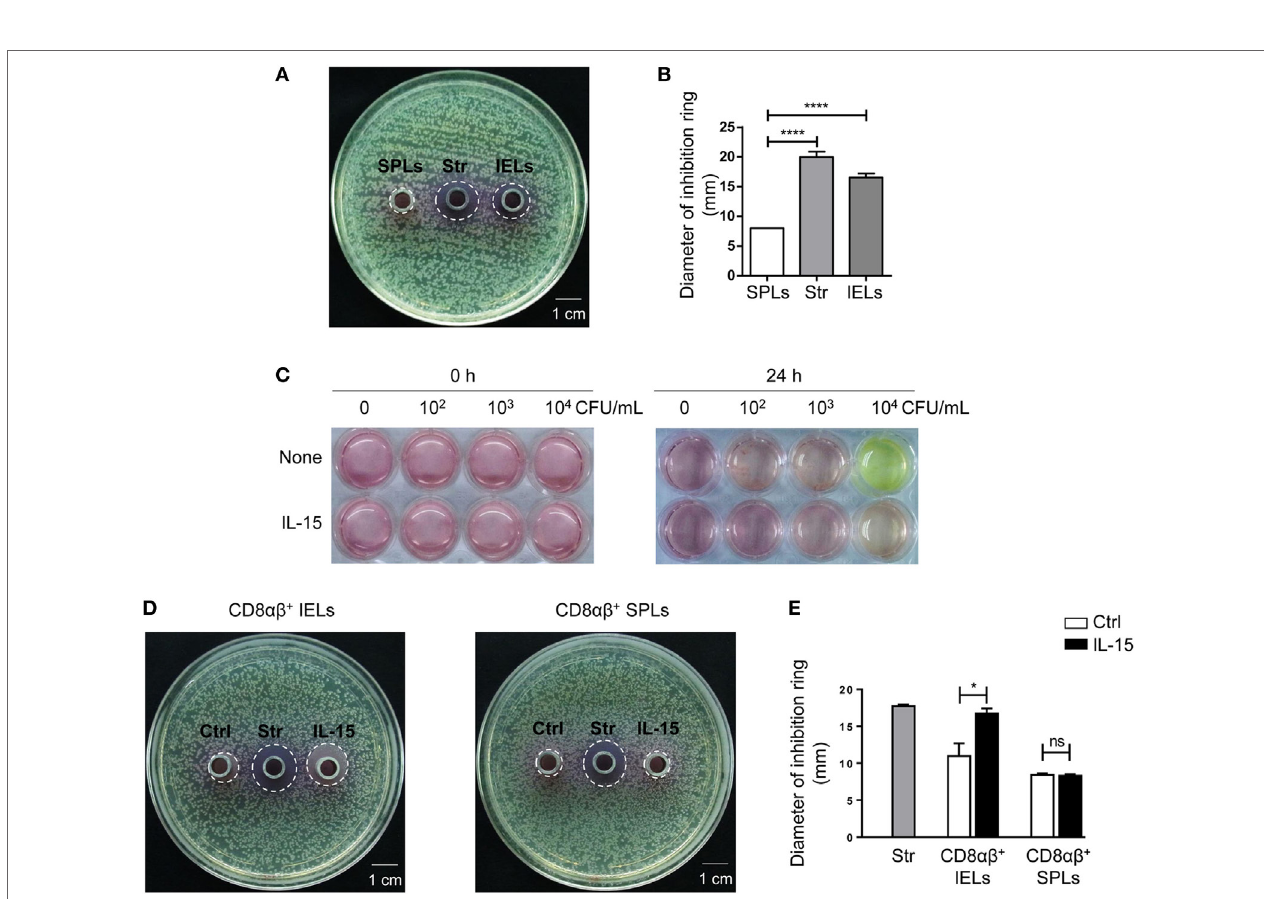
FigUre 5 | The supernatant from CD8 αβ + IELs can inhibit the formation of bacterial colonies directly. (a,B) CD8 αβ + IELs and CD8 αβ + SPLs were sorted and cultured for 24 h, with activation by PMA and ionomycin during the final 6 h. After 24 h, the supernatants were collected for an antimicrobial-activity assay. Iscove’s modified Dulbecco’s medium (IMDM) with streptomycin (0.1 mg/mL) was added to the middle Oxford cup as a positive control (labeled as “Str,” middle). Supernatants from CD8 αβ + SPLs (labeled as “SPLs,” left) and CD8 αβ + IELs (labeled as “IELs,” right) were added into Oxford cups, respectively, on the left and right side of the agar plate (a) . Inhibition rings were observed after 18 h. The diameter of the inhibition rings was measured and is shown in (B) . One-way ANOVA followed by Dunnett’s test. Each cell sample was sorted from 5 wild-type mice. Data are representative of three independent experiments; error bars represent the mean ± SEM. **** P < 0.0001. (c) IELs (1 × 10 6 cells) and increasing concentrations of Escherichia coli (CFU/mL), indicated in the Figure, were co-cultured with or without IL-15. The color of the medium indicated the acidity produced by bacterial proliferation. Data are representative of three independent experiments. (D,e) CD8 αβ + IELs were sorted and cultured with or without the IL-15/IL-15R complex for 24 h, after which the supernatants were collected for an antimicrobial- activity assay. IMDM with streptomycin (0.1 mg/mL) was added to the middle Oxford cup as a positive control (labeled as “Str,” middle). Oxford cups containing supernatants from CD8 αβ + IELs activated without (labeled as “Ctrl,” left) or with (labeled as “IL-15,” right) the IL-15/IL-15R complex were located, respectively, on the left and right side of the agar plate (D) . Inhibition rings were observed after 18 h. The diameter of the inhibition rings was measured and is shown in (e) . Unpaired t -test. Each cell sample was sorted from 5 wild-type mice. Data are representative of two independent experiments. Error bars represent the mean ± SEM. * P < 0.05. Abbreviations: ns, not significantly different; IEL, intraepithelial lymphocyte; SPL, splenocyte; Str, streptomycin.